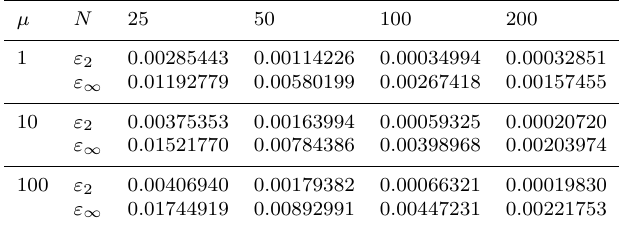
Table 3. Error of the solution at various